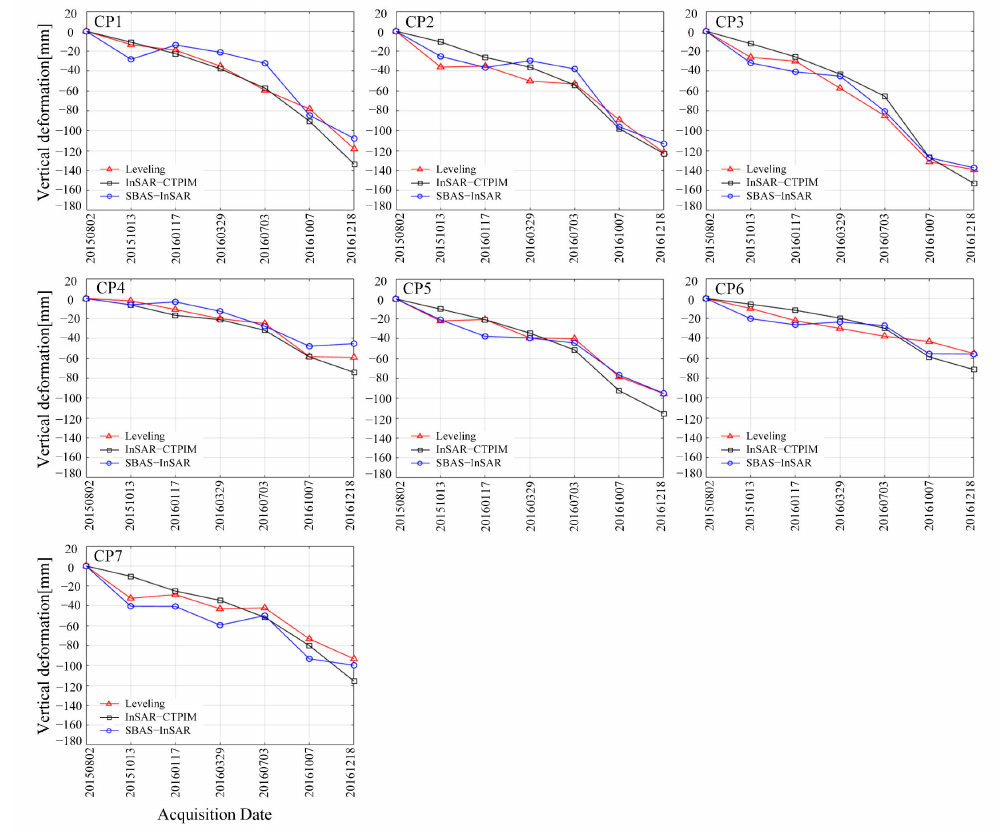
Figure 14. Time series deformation at leveling points (reference date: 2 August